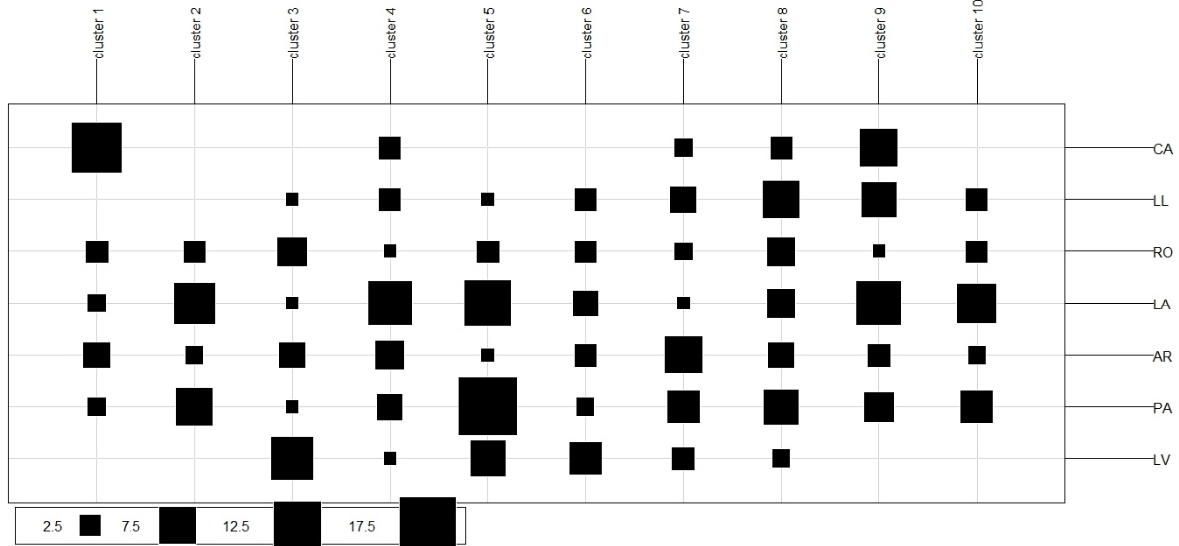
Figure 12. Genetic structure distribution graph. The number of individuals belonging to each sampled population is observed. La Veguilla (LV), Las Lomas (LL), Los Avellanos (LA), Punta de Á guila (PA), Armerillo (AR), Robler í a (RO), and Canelillo